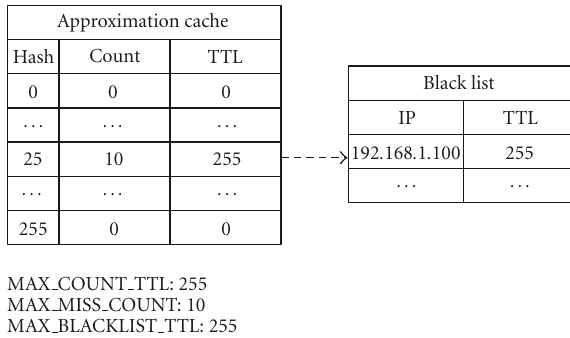
Figure 2: Structures used by the ESD Component.. 192.168.1.100 hashes to entry 25 in the approximation cache.. At the time of the hit, the count at that location was nine. Therefore, the count was incremented and the TTL is set to MAX COUNT TTL. Since the count is no longer less than MAX MISS COUNT, 192.168.1.100 is added to the black list with a TTL set to MAX BLACKLIST